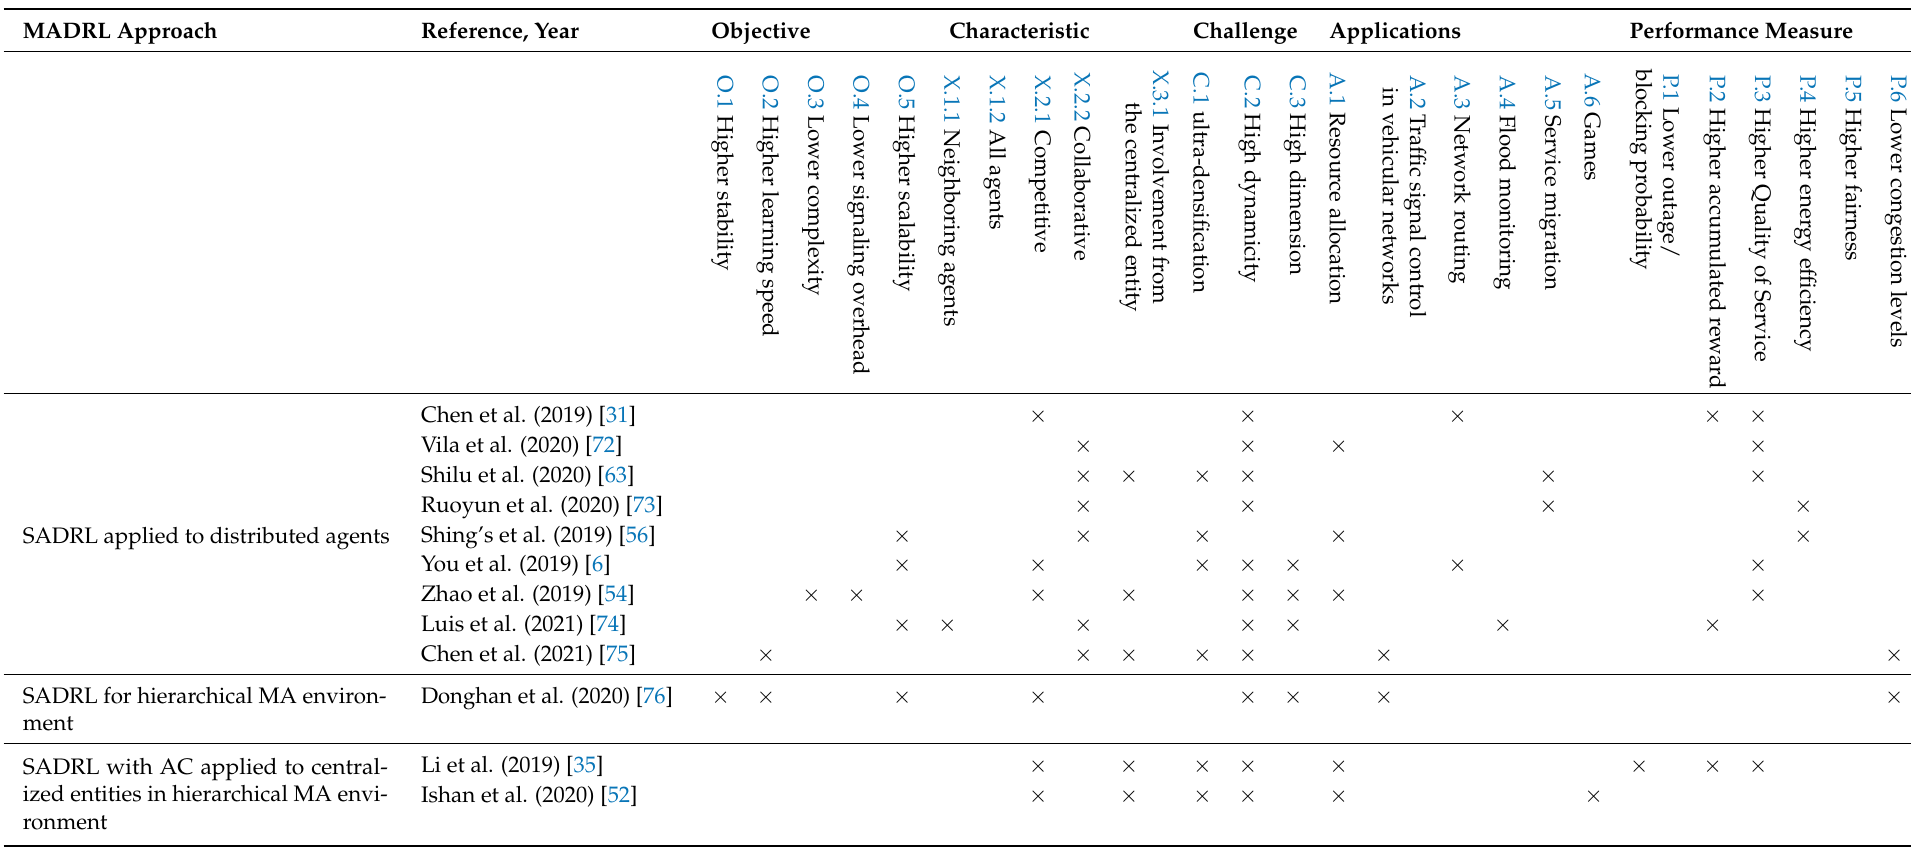
Table 4. Summary of MADRL approaches applied in various state-of-the-art